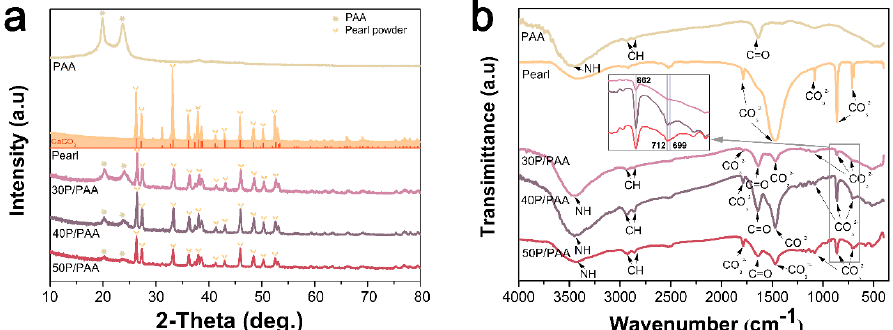
Figure 2. XRD ( a ) and FTIR ( b ) of the pearl, PAA, and the P/PAA composites.